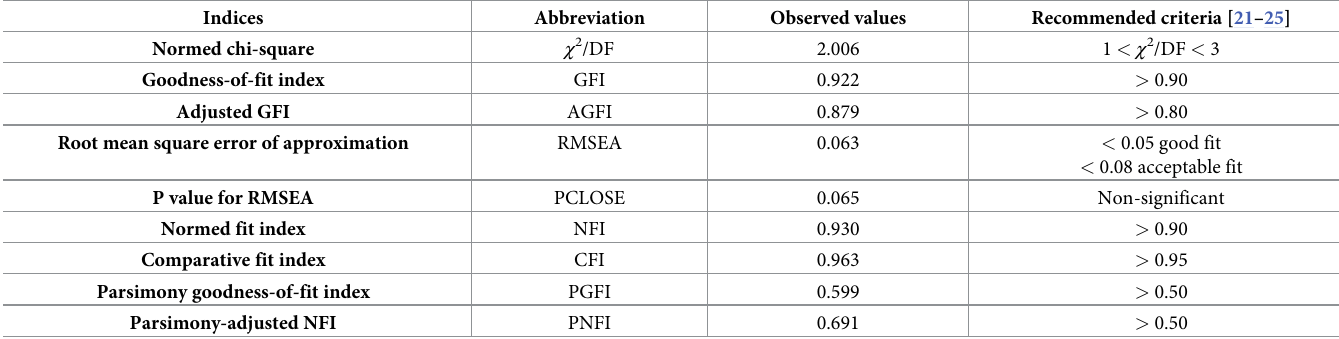
Table 9. Fit indices statistics in CFA ( N = 253).